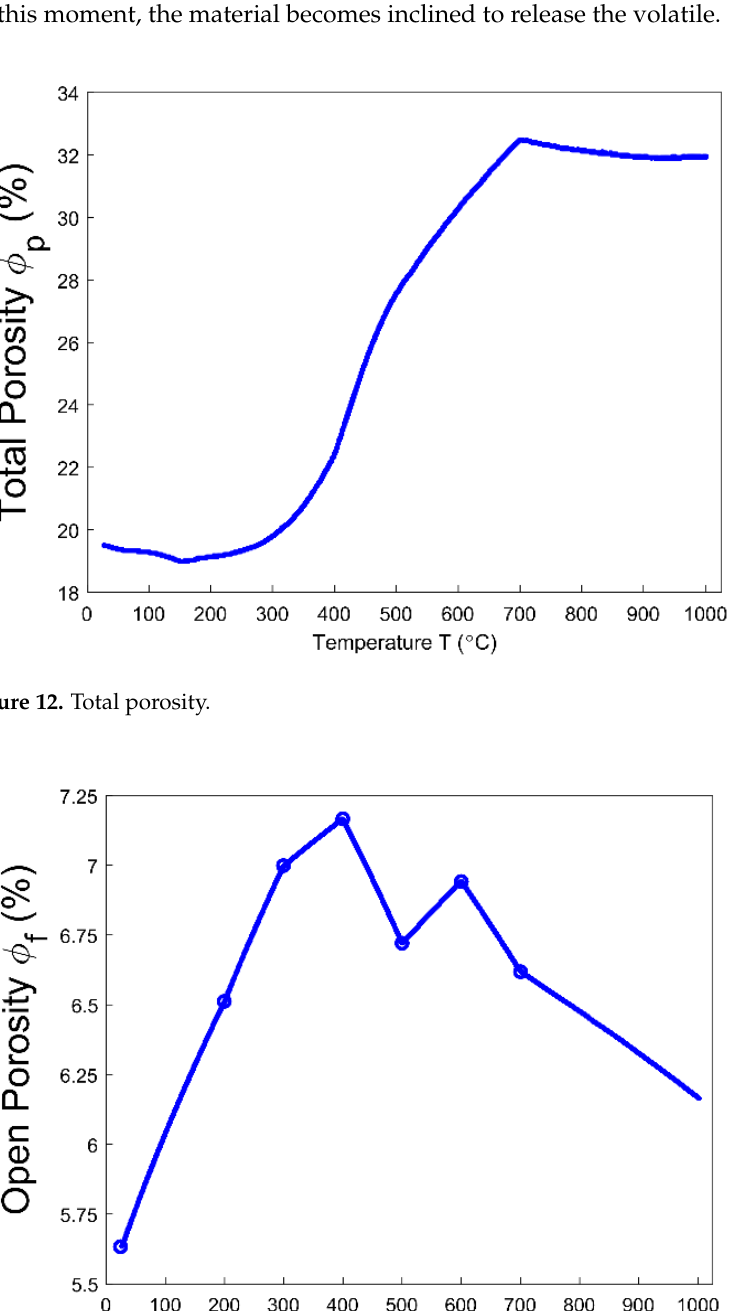
Figure 14. Total closed porosity. Figure 15. Closed porosity in filler coke aggregates.